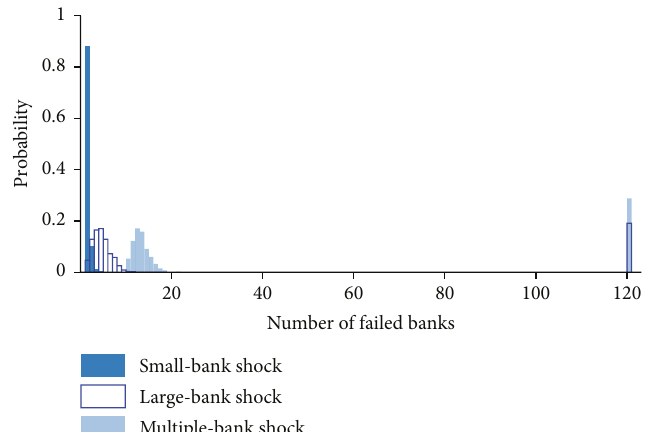
Figure 5: Probability distribution of number of failed banks in the complete information (CI) scenario after a shock is applied to a small bank, a large bank, and multiple small banks. The systemic breakdown occurs with sizable probability of nearly 20% and 30% after a large-bank shock and multiple-bank shock, respectively.